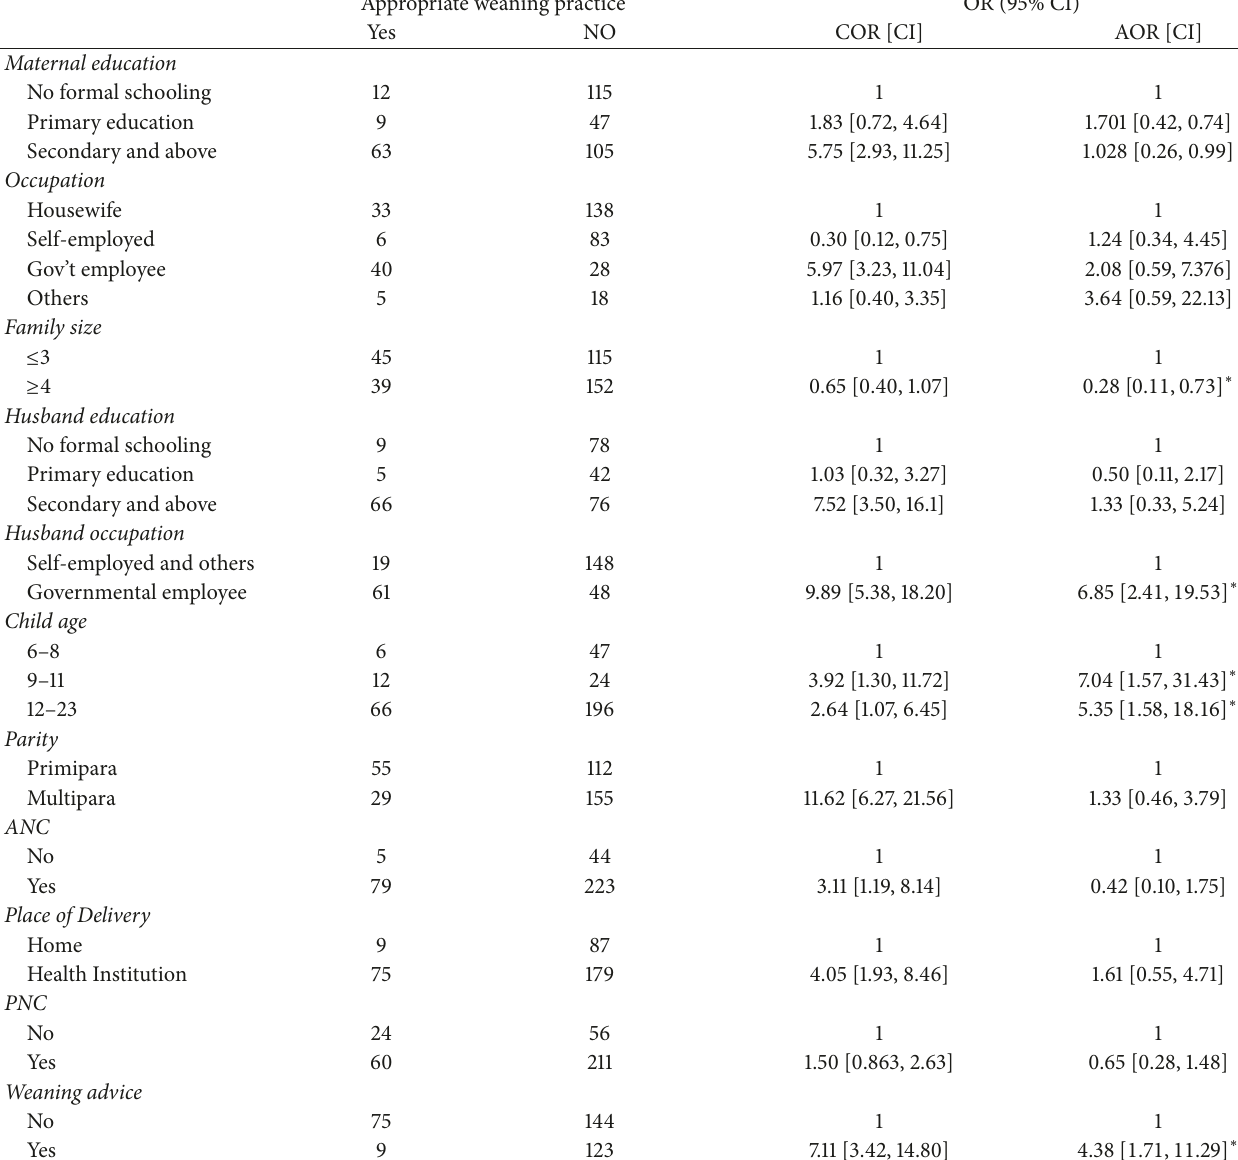
Table 4: Factors associated with weaning practice in Feres Bet Town, Ethiopia,